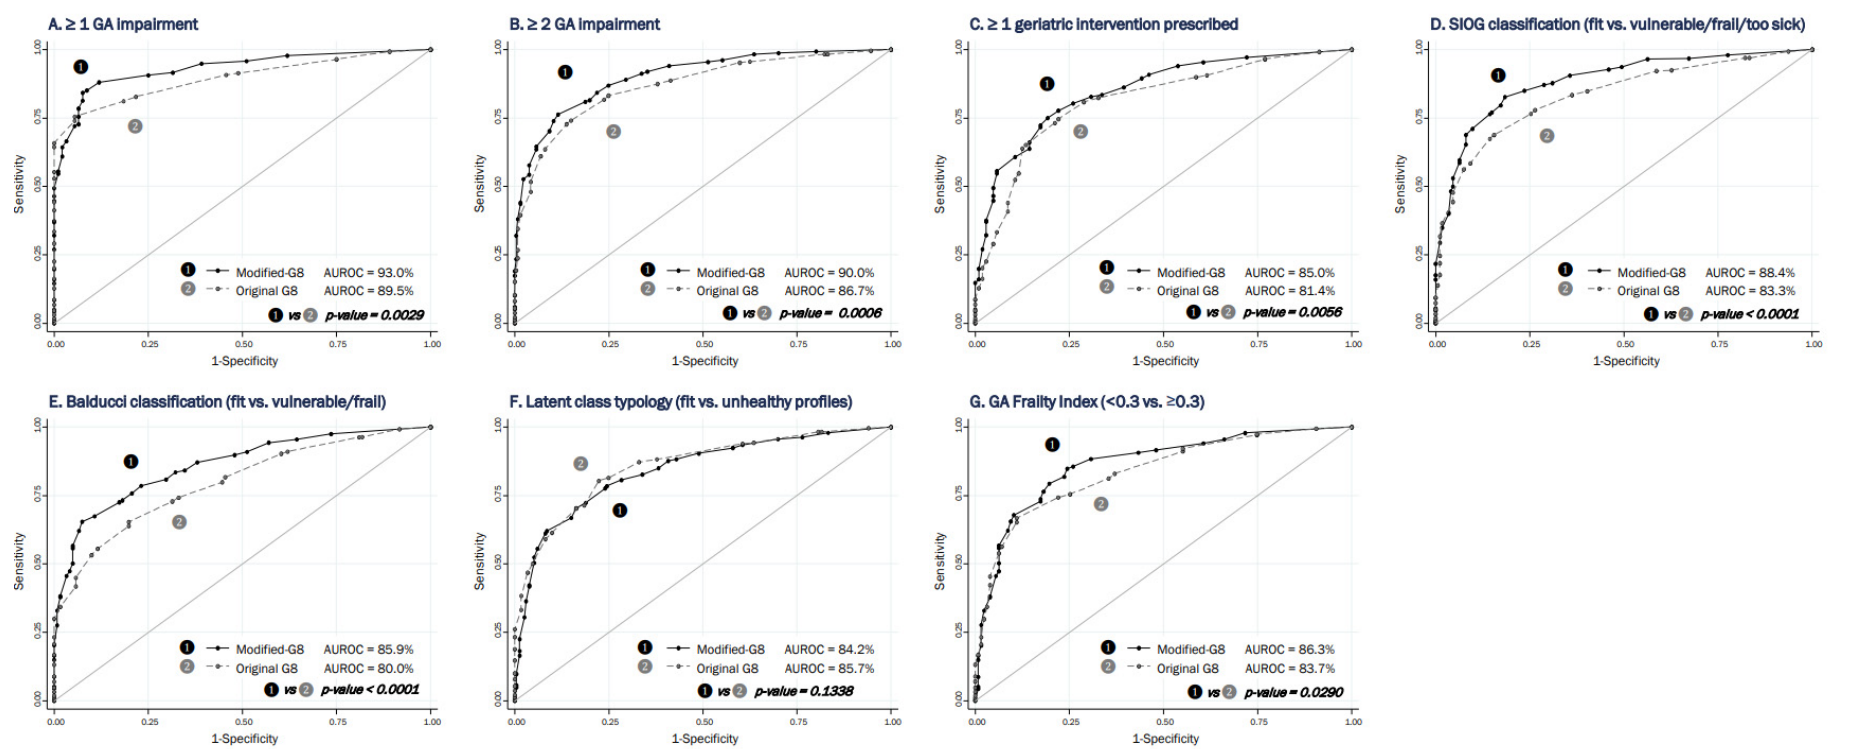
Figure 2. Receiver operating characteristic (ROC) curves for predicting different reference standard definitions: original vs. modified G8 questionnaire. ( A ) ≥ 1 GA impairment; ( B ) ≥ 2 GA impairments; ( C ) ≥ 1 geriatric intervention prescribed; ( D ) SIOG classification (fit vs. vulnerable/frail/too sick); ( E ) Balducci classification (fit vs. vulnerable/frail); ( F ) latent class typology (fit vs. “unhealthy profiles”); ( G ) GA frailty index. AUROC: area under the ROC curve; GA: geriatric assessment; SIOG, International Society of Geriatric Oncology.